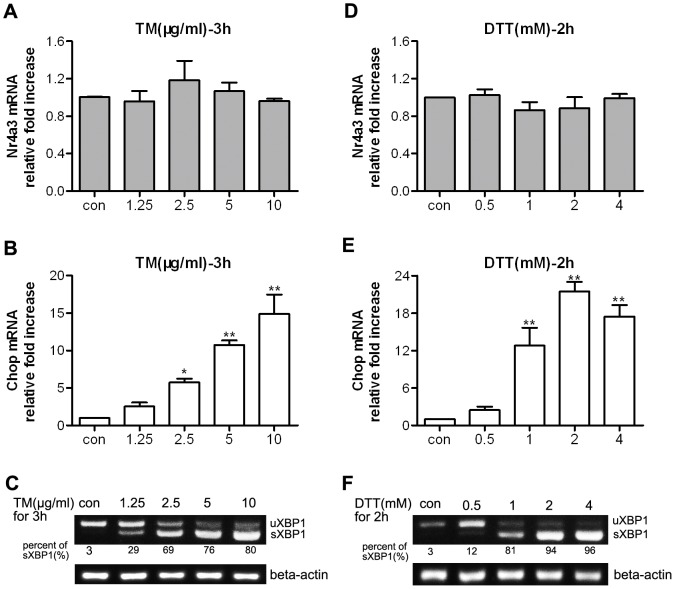
Tunicamycin or dithiothreitol treatment resulted in UPR activation but no NR4A3 increase in MIN6 cells.(A, B) Relative mRNA levels of NR4A3 and Chop, respectively, determined with real-time quantitative PCR in response to different doses of tunicamycin (TM) in MIN6 cells. (D, E) Relative mRNA levels of NR4A3 and Chop, respectively, determined with real-time quantitative PCR in response to different doses of dithiothreitol (DTT) in MIN6 cells. (C, F) Spliced XBP1 (sXBP1) mRNA formation in response to different (C) TM or (D) DTT doses, respectively. Two forms of XBP1 (a UPR molecule) was detected with reverse transcription PCR. Data are shown as mean ± S.E. (n = 4). * p<0.05, ** p<0.01 vs. con (vehicle control group).